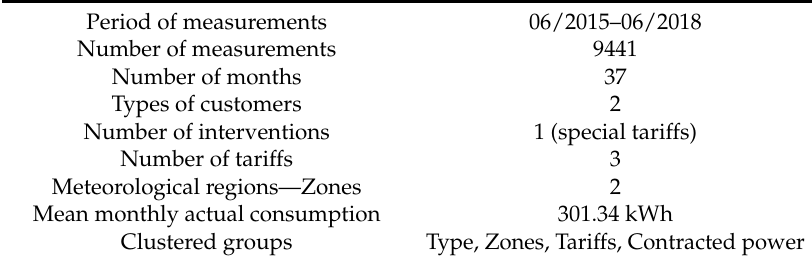
Table 2. Highlights of Coopérnico’s dataset.